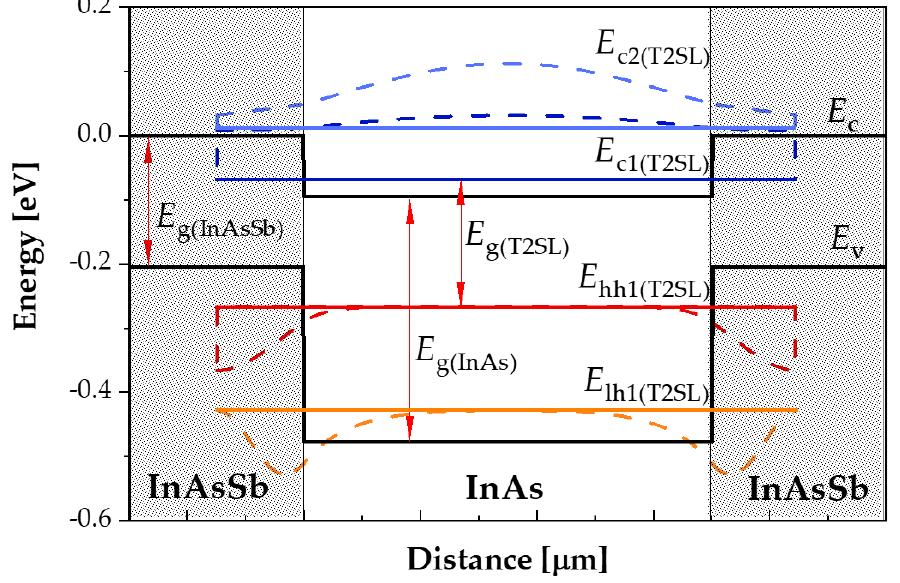
Figure 1. Plot of the T2SL energy bands. ( E c —conduction band, E v —valence band, E g —bandgap energy, E c1,c2 —electron band, E hh1 —heavy hole band, and E lh1 —light hole band). The black line represents the InAs 1 − x Sb x and InAs conduction and valence bands, while blue and red line represents the electron and hole mini-bands (heavy—hh1 and light—lh1) in InAs/InAs 1 − x Sb x T2SL. The blue and red dashed line represents the